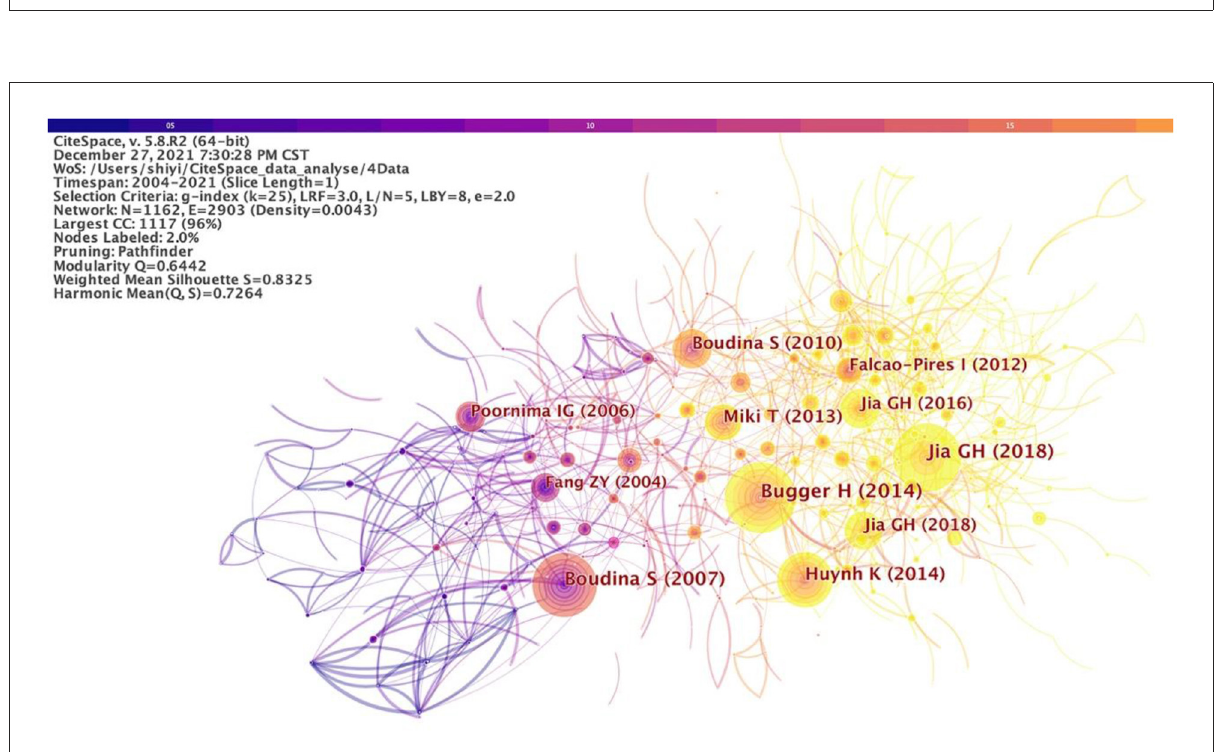
FIGURE7 Document co-citation analysis in DCM